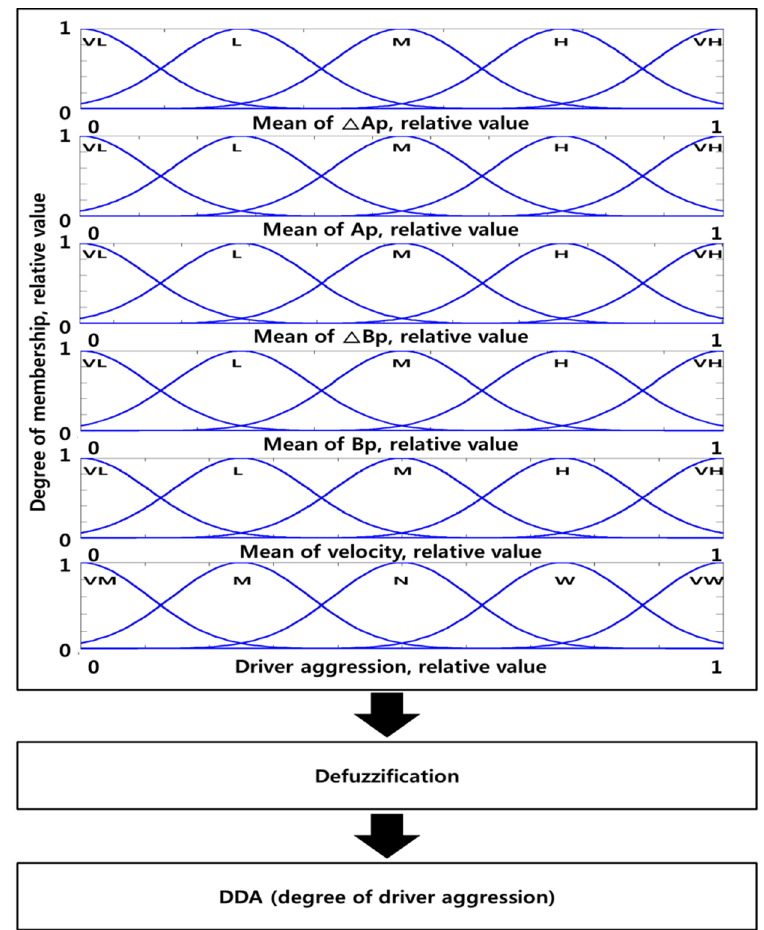
Figure 8. Block diagram of the DDA.